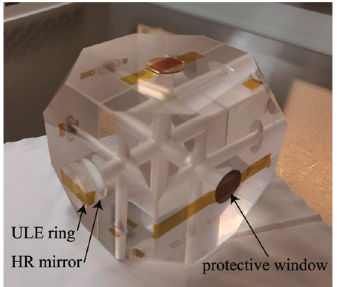
Figure 1. Homemade FP cavity with cubic shape.